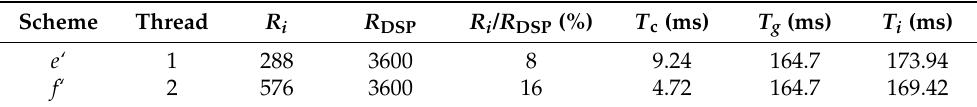
Table 8. Test results of coarse registration with different threads.